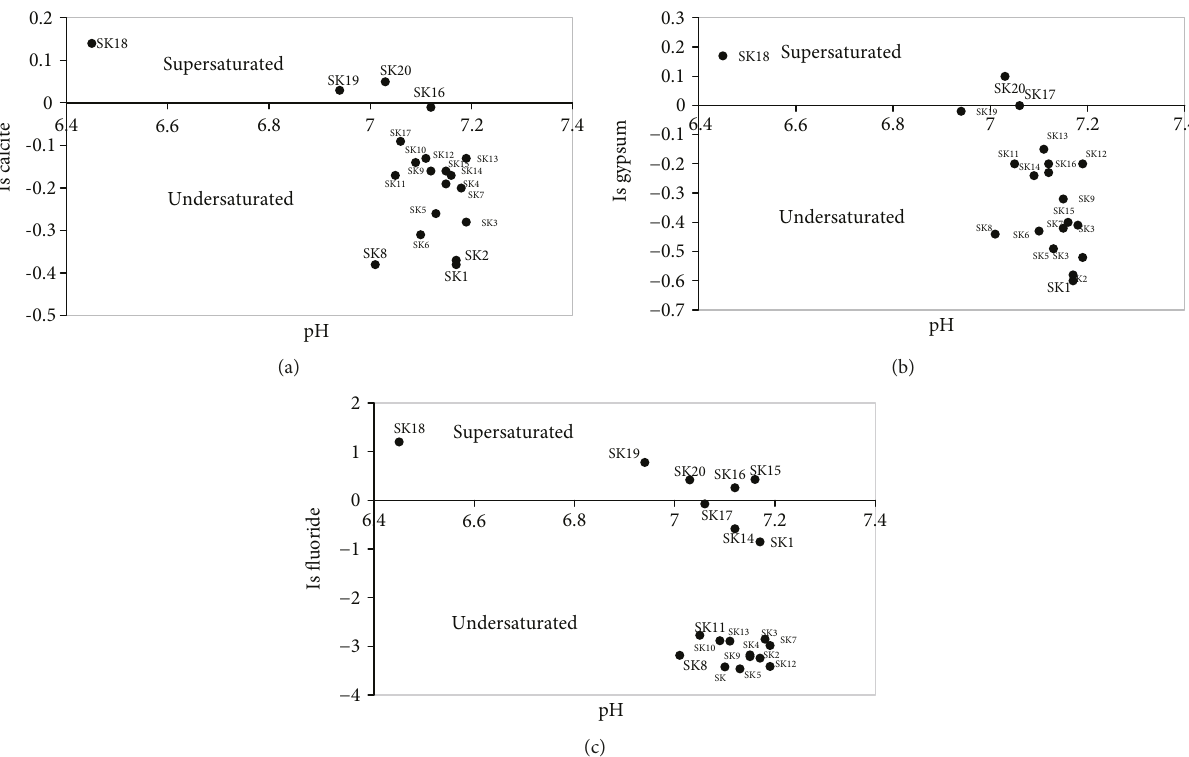
· 2H O (SI) versus pH (a). Saturation indexes of CaCO 4 2